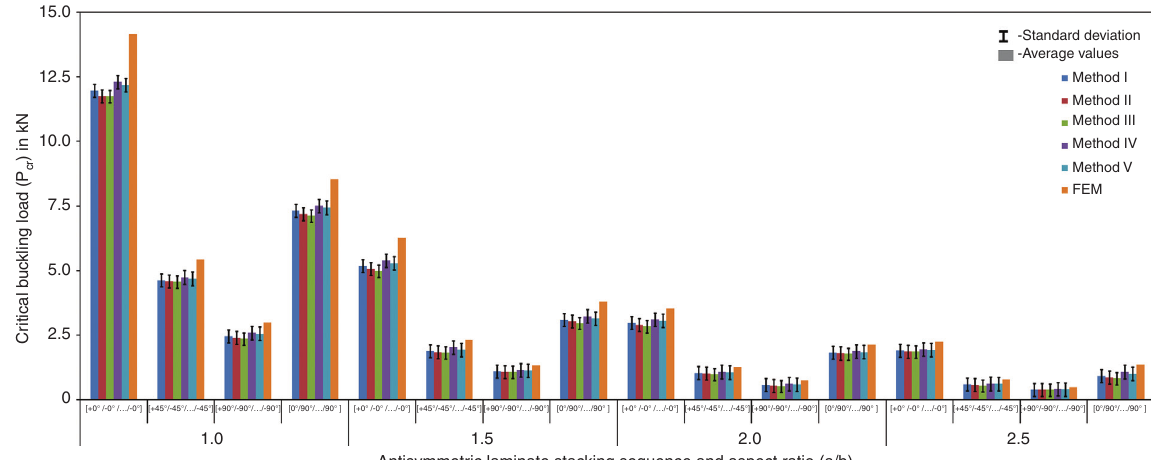
Figure 9 Critical buckling load for laminated skew plate ( α = 30 °